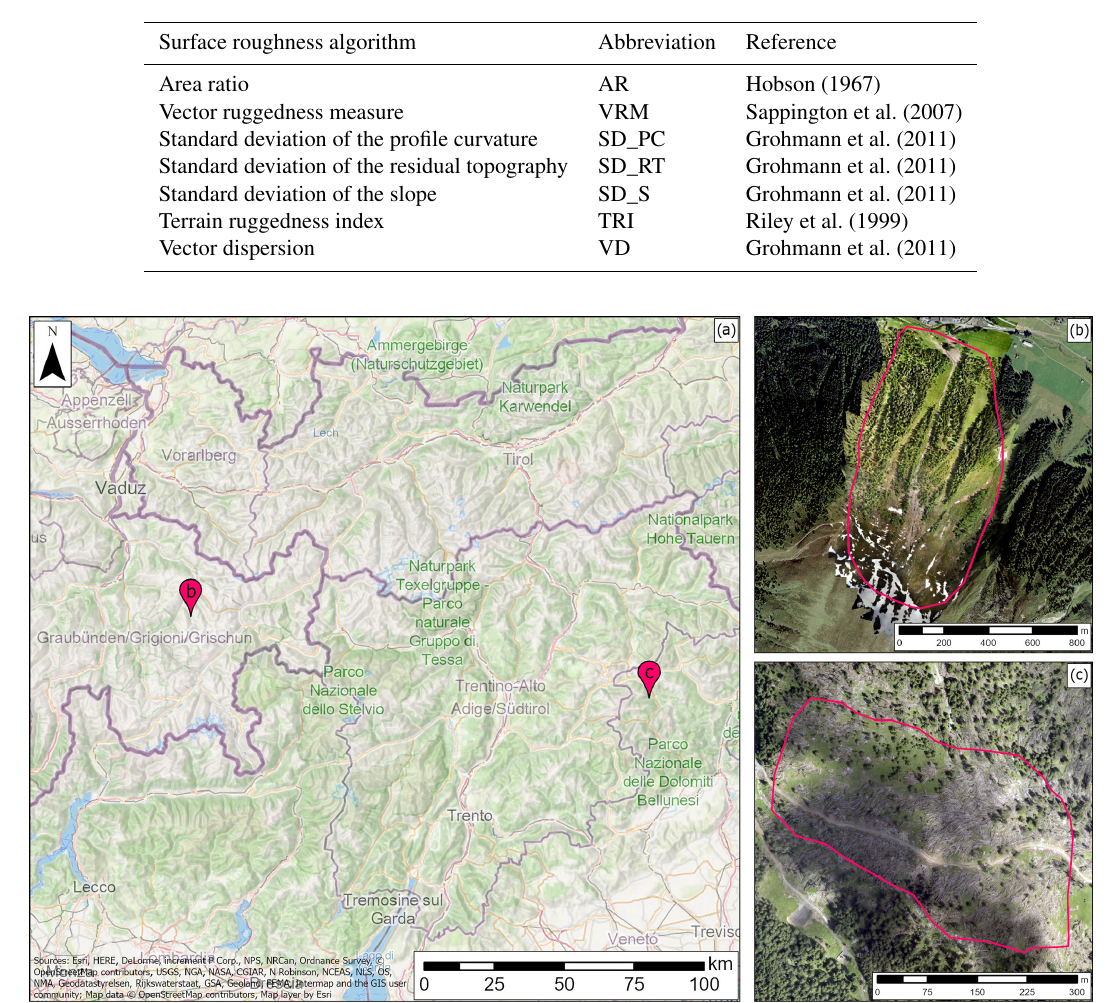
Figure 1. (a) Locations of the study areas in the central and eastern European Alps (map source: © OpenStreetMap contributors 2021; distributed under the Open Data Commons Open Database License (ODbL) v1.0.). (b) Braema, located close to Davos (Grisons, Switzerland; orthophoto in the background (© swisstopo, 2021) and orthophoto in the front from the drone flight 2019), and (c) Franza, located in the Dolomites (Veneto, Italy; orthophoto from the drone flight 2019).